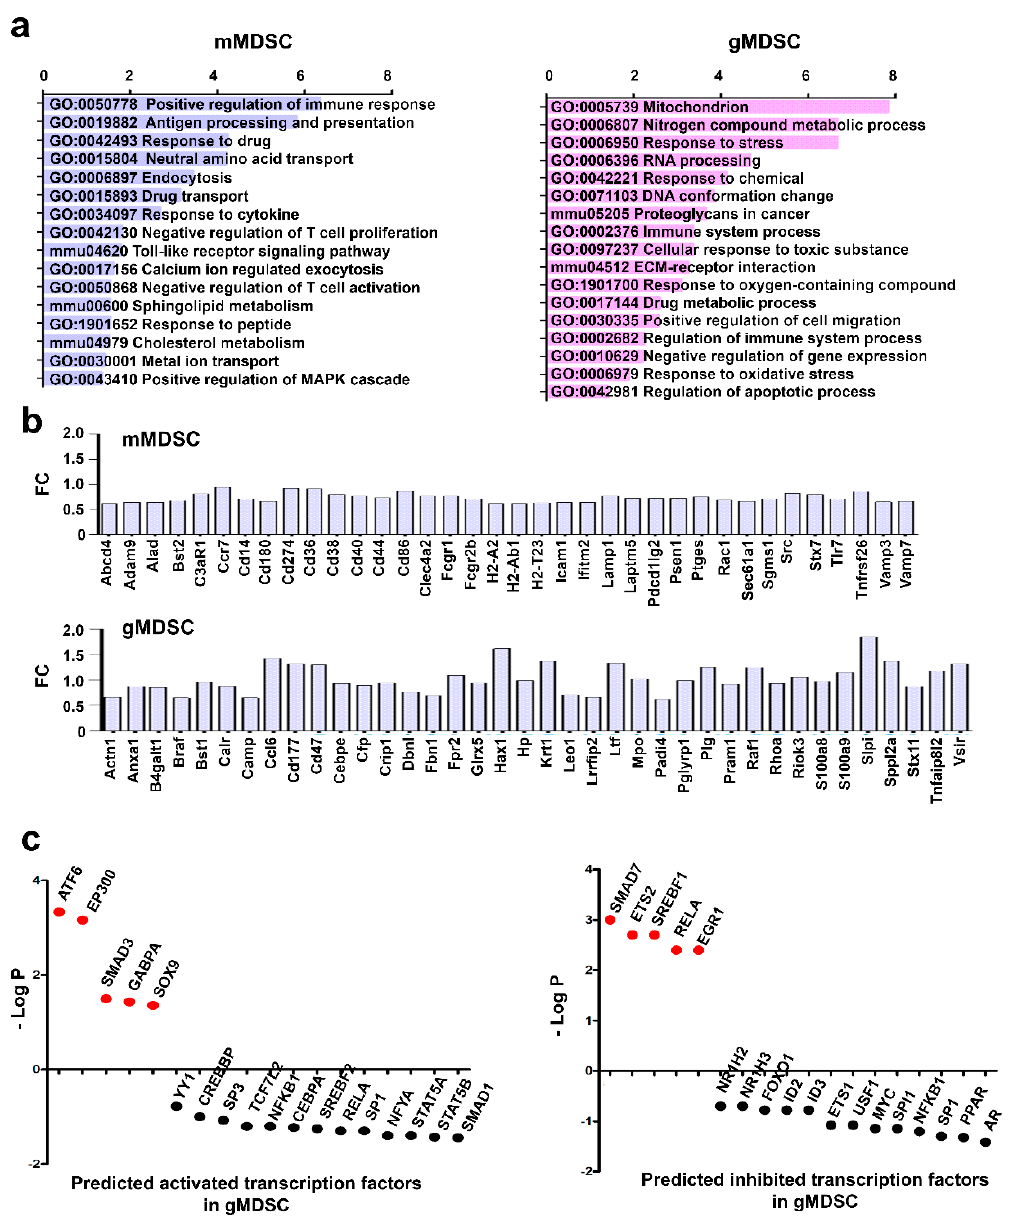
Figure 7. Monocytic and granulocytic-MDSCs differential pathways. ( a ) The bar graphs represent the enrichment of the differentially up-regulated pathways in the g-MDSC or m-MDSC proteome as indicated, as analyzed by gene ontology and KEGGs pathways. ( b ) The bar graphs represent the fold change in expression of the indicated selected immune modulators in the differential proteome of g-MDSC or m-MDSC as indicated. ( c ) The dot plot graphs represent the probability of each indicated transcription factor to be either activated (left graph) or inhibited (right graph) in g-MDSCs compared to m-MDSCs using the Tfacts algorithm. Transcription factors with statistical significance of association to the differential m-MDSC proteome according to probability ( P < 0.05) and false discovery rates (FDR < 0.05) are highlighted in red.